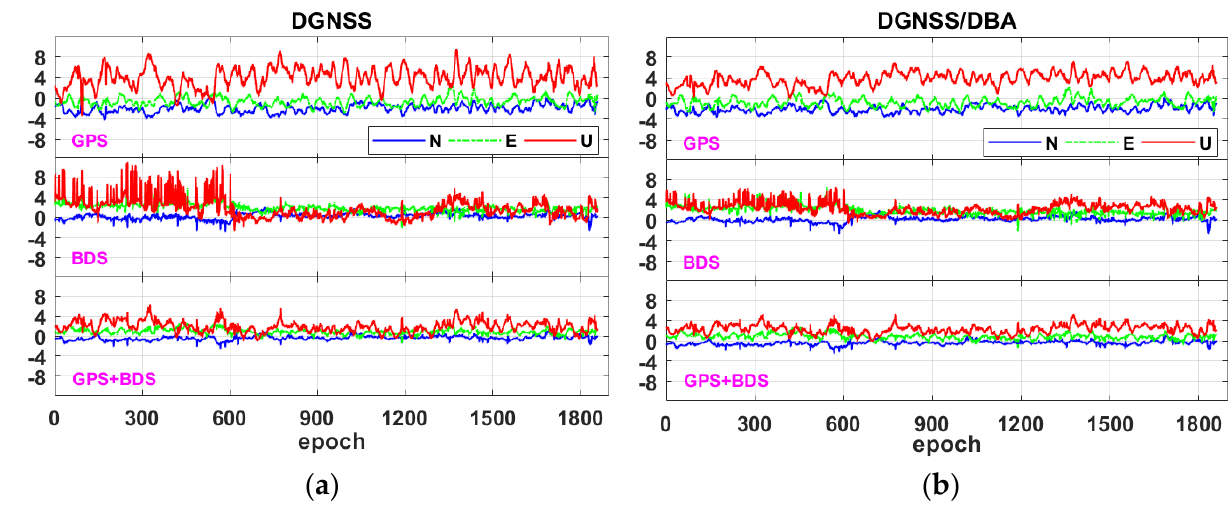
Figure 10. The deviation sequence diagram in the N/E/U directions at 6.0 km baseline length: ( a ) DGNSS positioning mode; ( b ) DGNSS/DBA positioning mode.